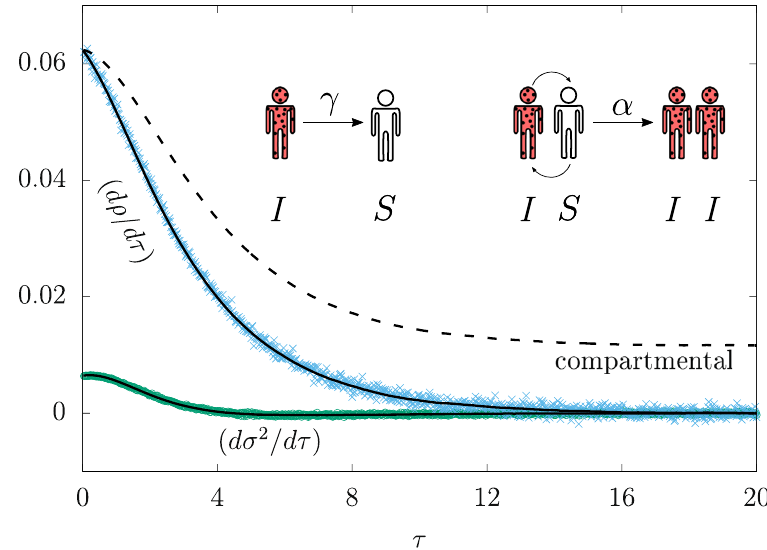
Figure 1. Numerical simulations of the SIS model. (inset) Infected hosts (I) recover to susceptible state (S) with rate γ (left). The adequate interaction between an infected host with a susceptible one may trigger a new infection, with rate α (right). Stochastic effects are far more relevant for small population sizes ( N = 50, γ / α = 1/2), reducing the accuracy of compartmental equations. The forward-derivative d ρ / d τ from data (cross) agrees with Eq. (5a) (solid line), while the compartmental equation Eq. (1) fails to reproduce the data (dashed line). The forward-derivative d σ 2 / d τ from data (circles) also agrees with the formula in Eq. (5b) (line). All the lines are drawn using the simulated data for 〈 ρ ( τ ) 〉 , σ 2 ( τ ), and Δ 3 ( τ